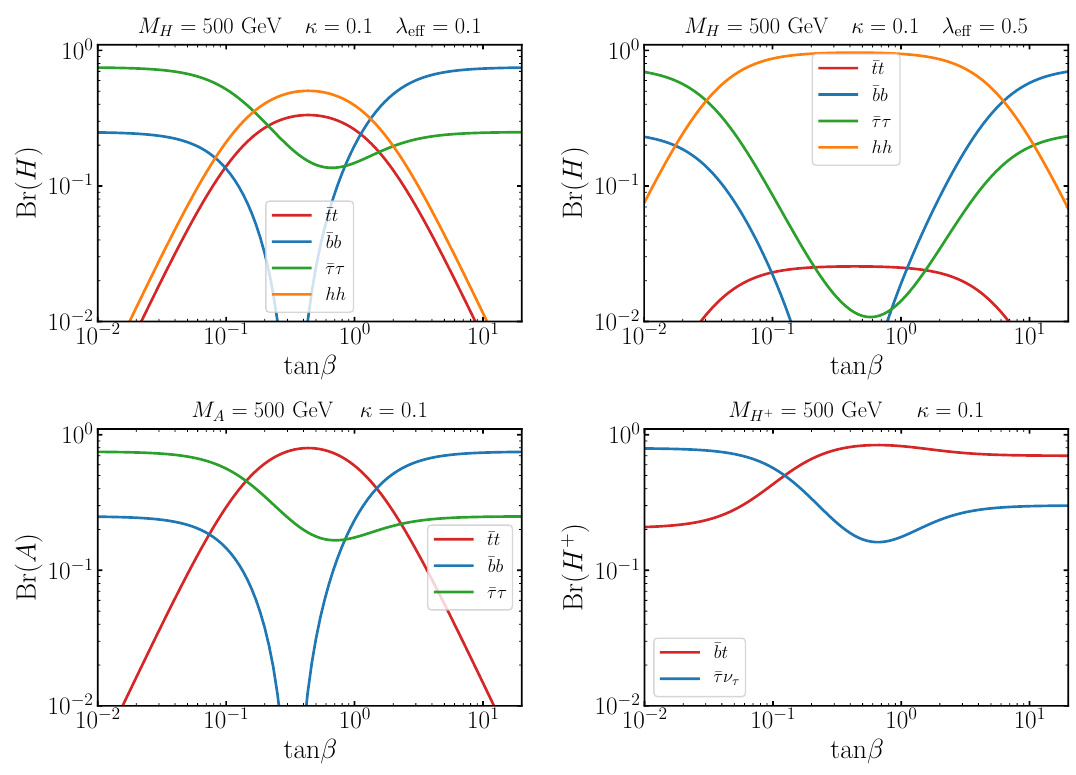
Figure 2 . Upper panel: branching ratio for the different decay channels of the scalar H as a function of the parameter tan β . Different plots correspond to different values for the H − h − h coupling λ and we fix κ = 0 . 1 and M = 500 GeV. Lower panel: on the left (right) panel we show eff H the branching ratio for the different decay channels of the pseudoscalar A (charged Higgs H ± ) as a function of the parameter tan β and we set M = M = 500 A H ±